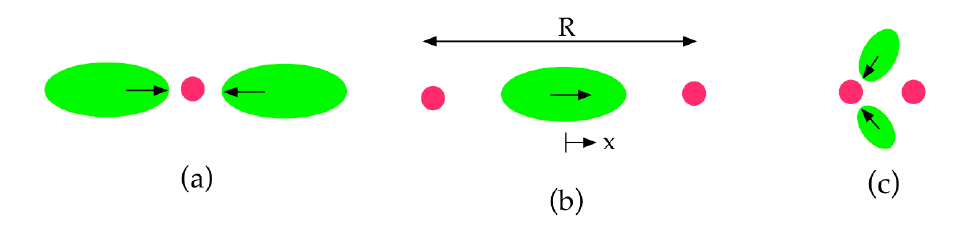
Figure 1. Classical depictions of the electromagnetic configurations for ( a ) the tresino, ( b ) the ptre and ( c ) the proton-tresino molecule (PTM) with individual components, protons in red and electrons in